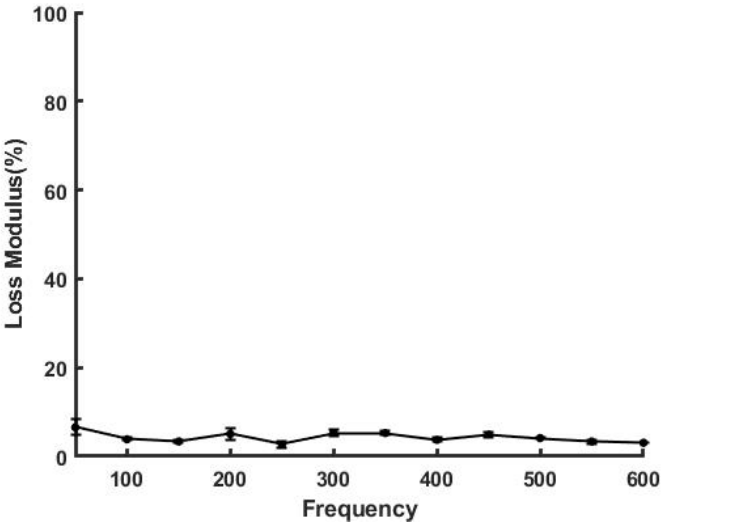
Figure 7. Loss modulus as a % of the elastic modulus for silicone rubber. Note the loss modulus of silicone rubber is only about 4% at most frequencies.